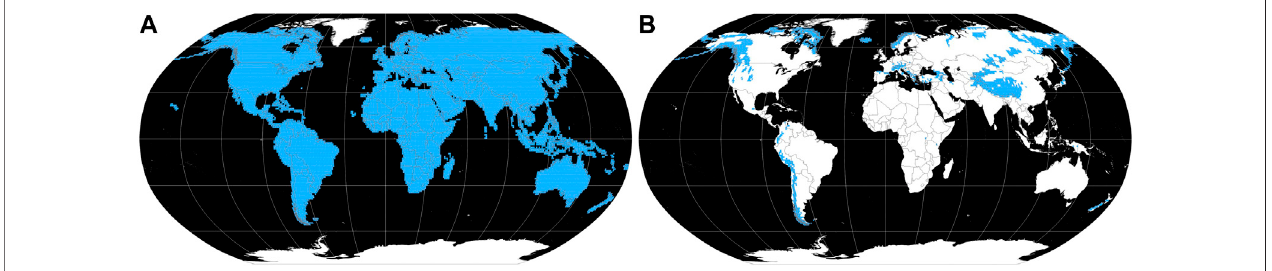
FIGURE 1 | (A) Landsat GLAD ARD data extent (highlighted in blue). (B) Extent of perennial snow and ice mapping (highlighted in blue).